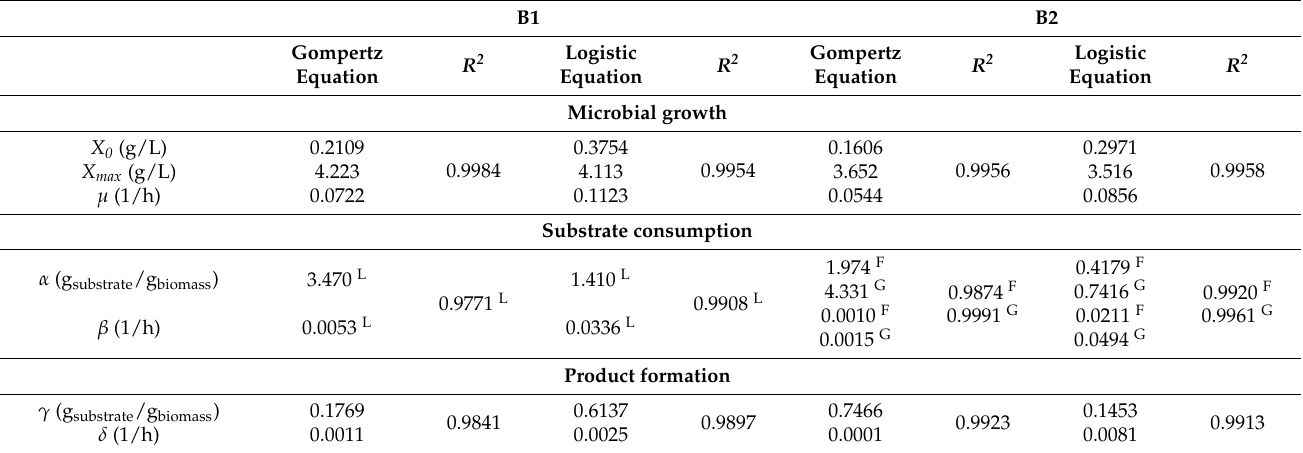
Table 2. Kinetic parameters related to microbial growth, substrate consumption and product forma- tion during the cultivations of Bacillus sp. BioSol021 in a 16 L bioreactor using the food